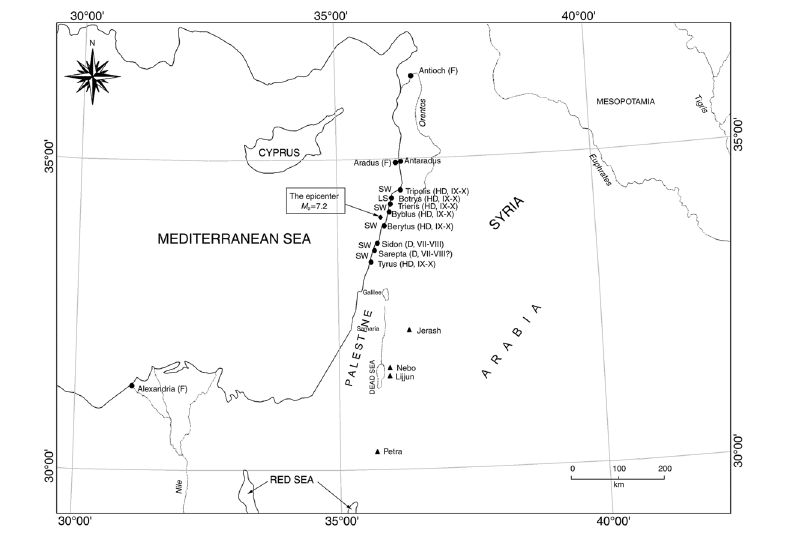
Fig. 5. Map of intensity distribution for July 9, 551 A.D. earthquake. F – felt; D – damage; LS – landslide, and SW – Sea-Wave. Triangles represent possible damaged archaeological sites (Darawcheh et al. ,